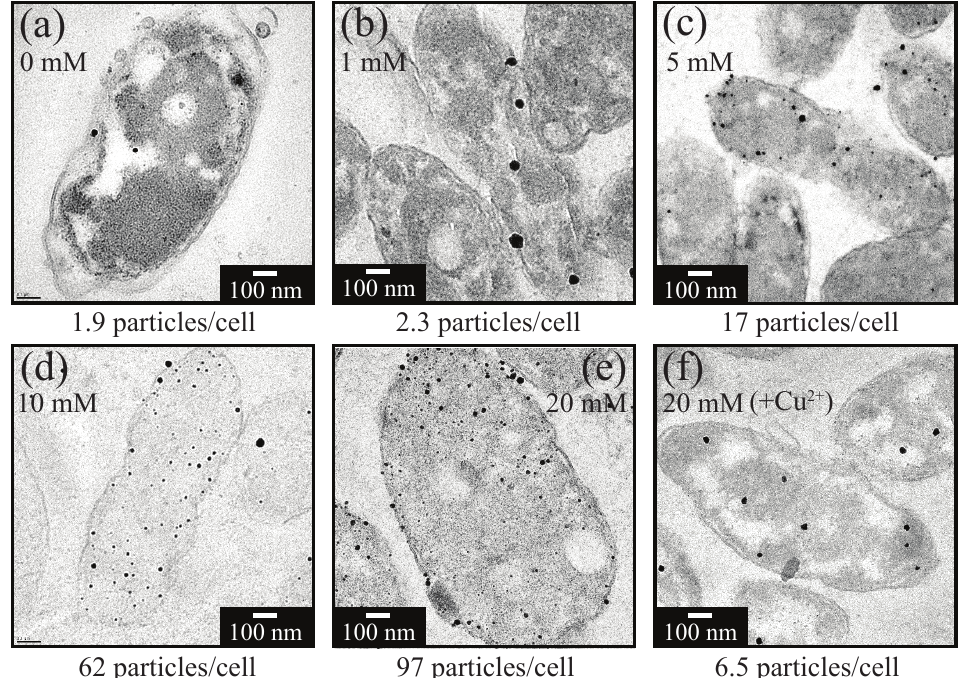
Figure 5. Ultra-thin section TEM images of Ac. aromatica cells collected at 160 h after exposure to 10 mg / L Au(III). Formate was added as e-donor at; ( a ) 0 mM, ( b ) 1 mM, ( c ) 5 mM, ( d ) 10 mM, or ( e ) 20 mM. ( f ) As a possible enzymatic inhibitor, 5 mM Cu 2 + was simultaneously added together with 20 mM formate. Densities of Au(0) bionanoparticles (NPs / cell) were calculated and indicated underneath respective TEM images. The total number of particles counted were as follows: ( a ) n = 25 (in 13 cells); ( b ) n = 18 (in 8 cells); ( c ) n = 119 (in 7 cells); ( d ) n = 493 (in 8 cells); ( e ) n = 681 (in 7 cells); and, ( f ) n = 71 (in 11